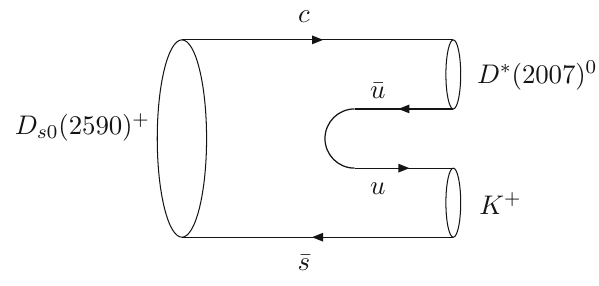
Fig. 2 Dominant decay channel D s 0 ( 2590 ) + → D ∗ ( 2007 ) 0 K + ( D s 0 ( 2590 ) + → D ∗ ( 2010 ) + K 0 when u ¯ u is changed to d ¯ d